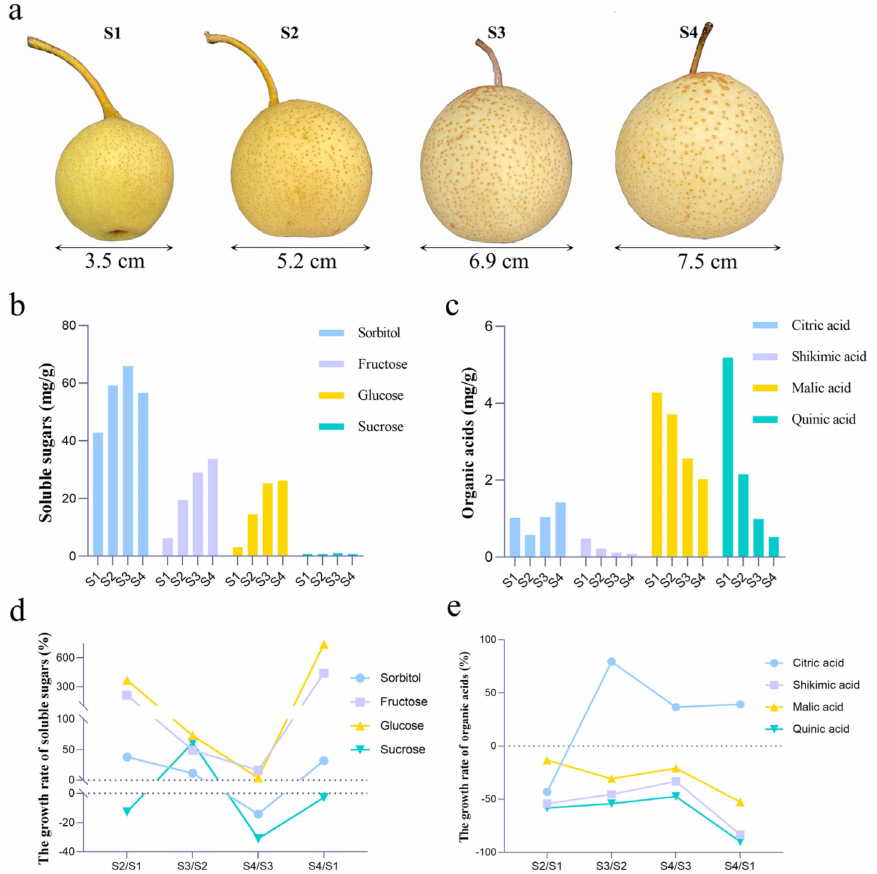
Figure 1. Phenotypic analysis of ‘Panguxiang’ in four growth and development stages. ( a ) The phenotype of ‘Panguxiang’ at the four stages [23]. Determination of ( b ) sugar content and ( c ) organic acid content. ( d , e ) The growth rate of sugar and organic